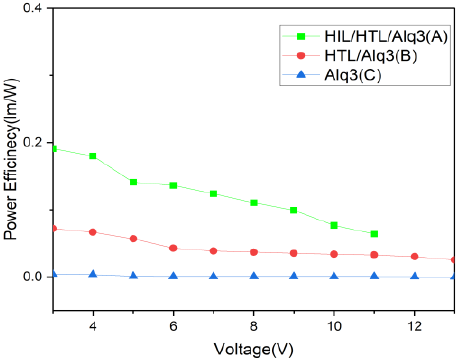
Figure 6. The curves of Power efficiency and Voltage characteristics with linear–linear scale.